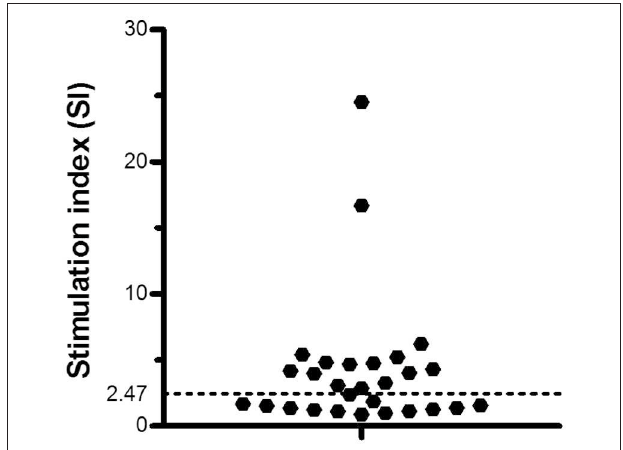
FIGURE 2 | T cell proliferation in asymptomatic immune responders . Cut off for the T cell proliferation stimulation index (SI) in individuals exposed to an endemic area of American Tegumentary Leishmaniasis (ATL). Black dotted line limits the cut